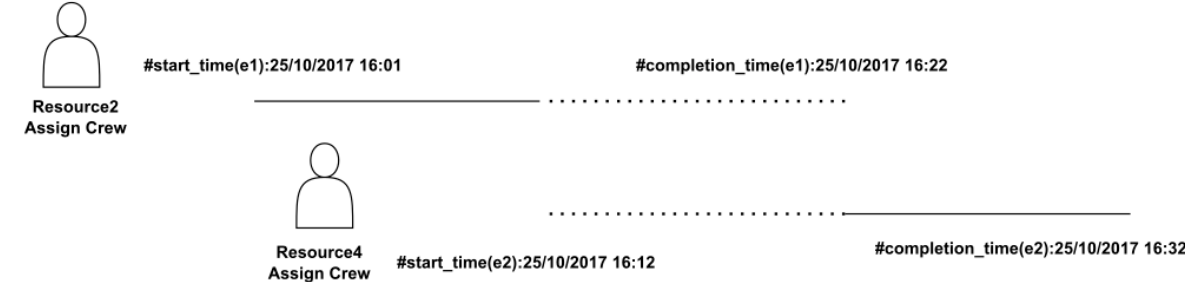
Figure 2. Co-worker Figure 2. Co ‐ worker network.